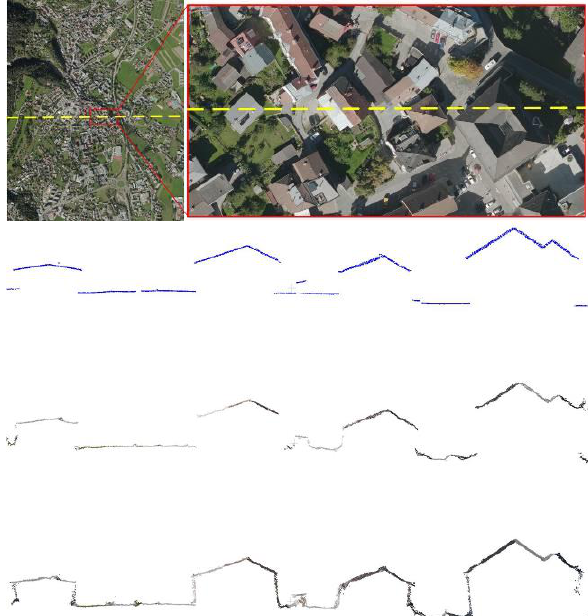
Figure 4. Height profiles in LiDAR (top), nadir (middle) and nadir + oblique (bottom) point clouds. The profile section is indicated in yellow in the